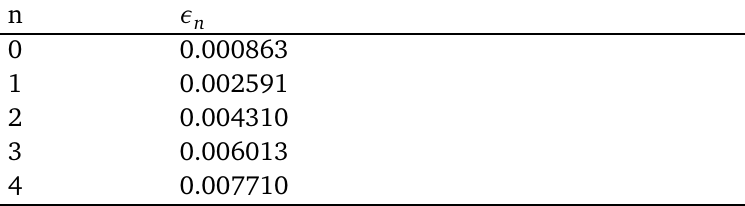
Table 2. Shifted eigenvalues for odd values of n ( J = 1, B = 1 /